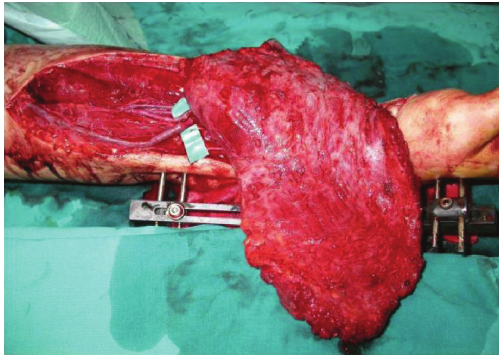
Figure 3: LD flap with anastomosis of the vessels.